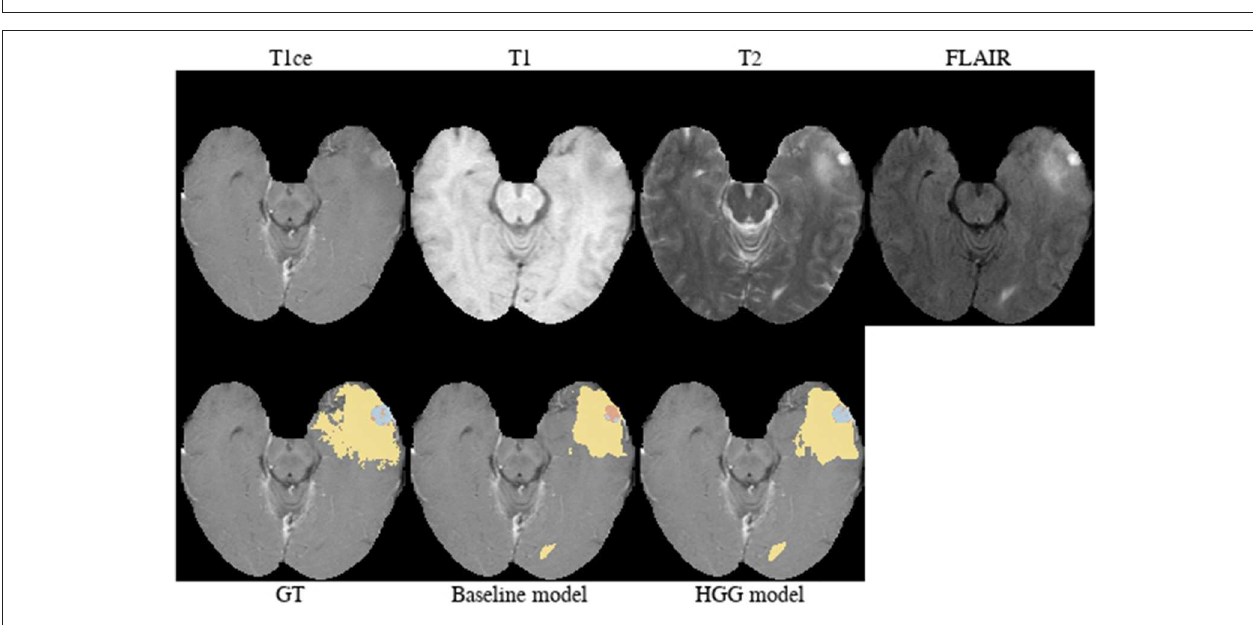
FIGURE 8 | Brats18_TCIA01_221_1.